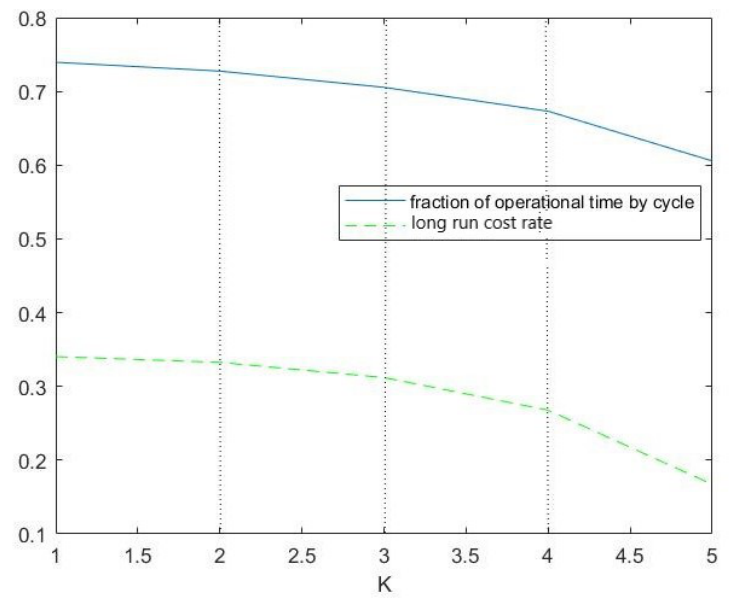
Figure 5. Fraction of operational time by cycle and the long-run cost rate versus K